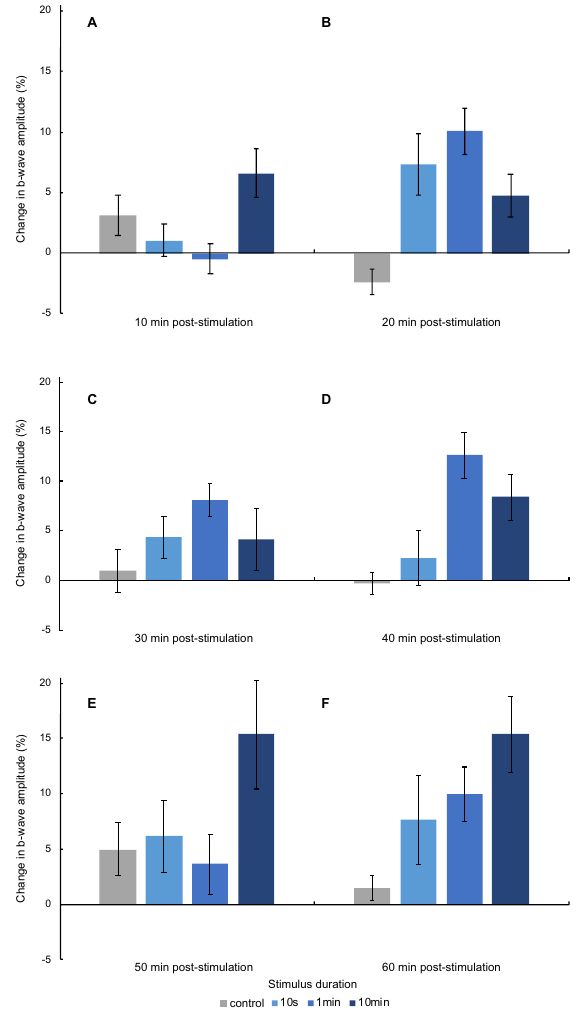
Figure 1. Mean and standard error of the mean (SEM) of the change in b-wave amplitude (%) relative to baseline after no stimulation and each stimulation protocol (10 s, 1 min, 10 min) are plotted at 10 min ( A ), 20 min ( B ), 30 min ( C ), 40 min ( D ), 50 min ( E ), and 60 min ( F ) after stimulation.